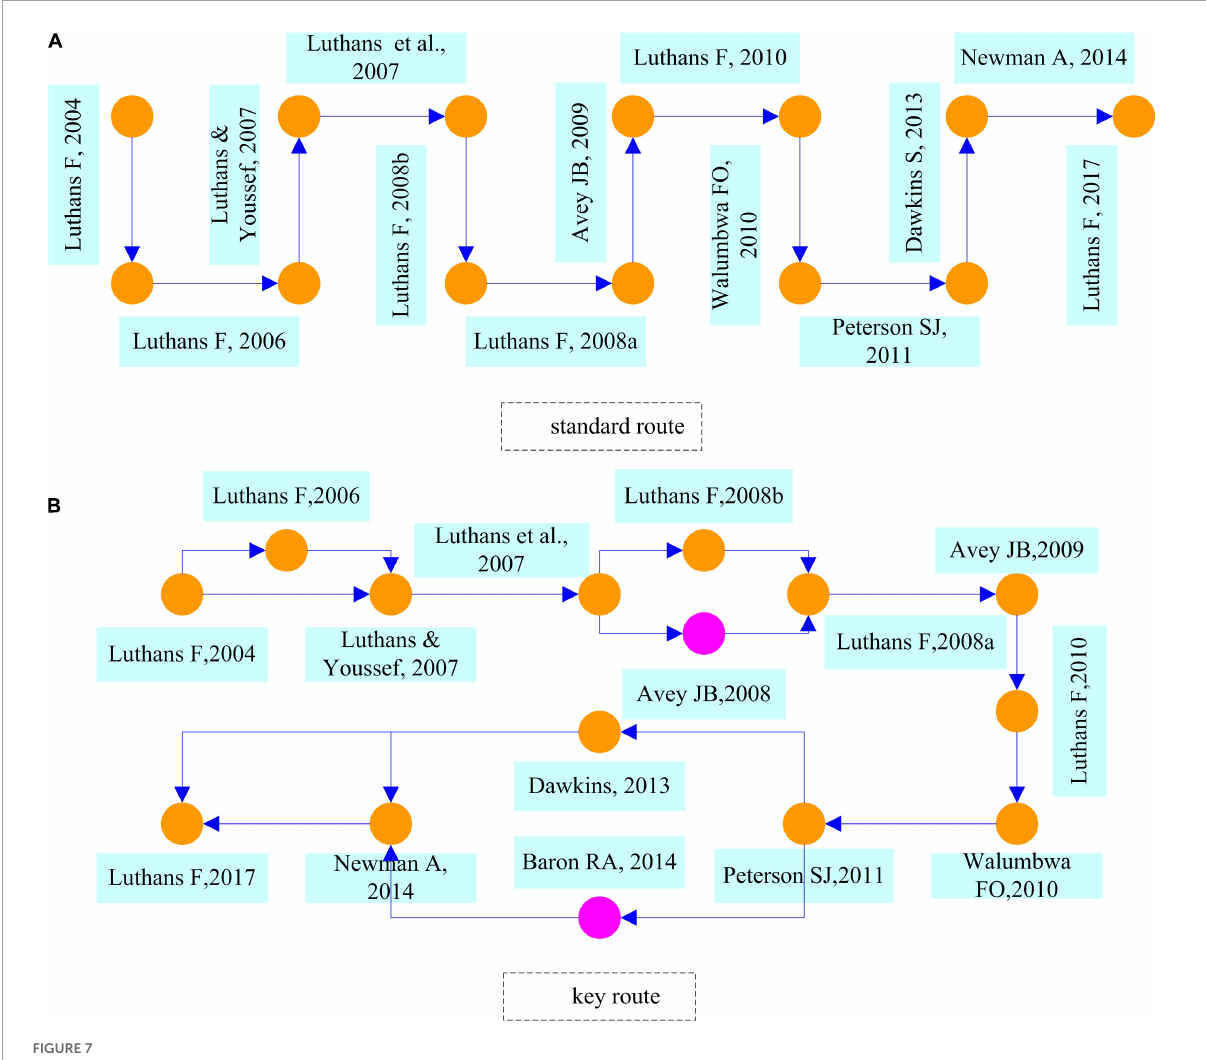
FIGURE7 Global standard route (A) and key route (B) in the field of